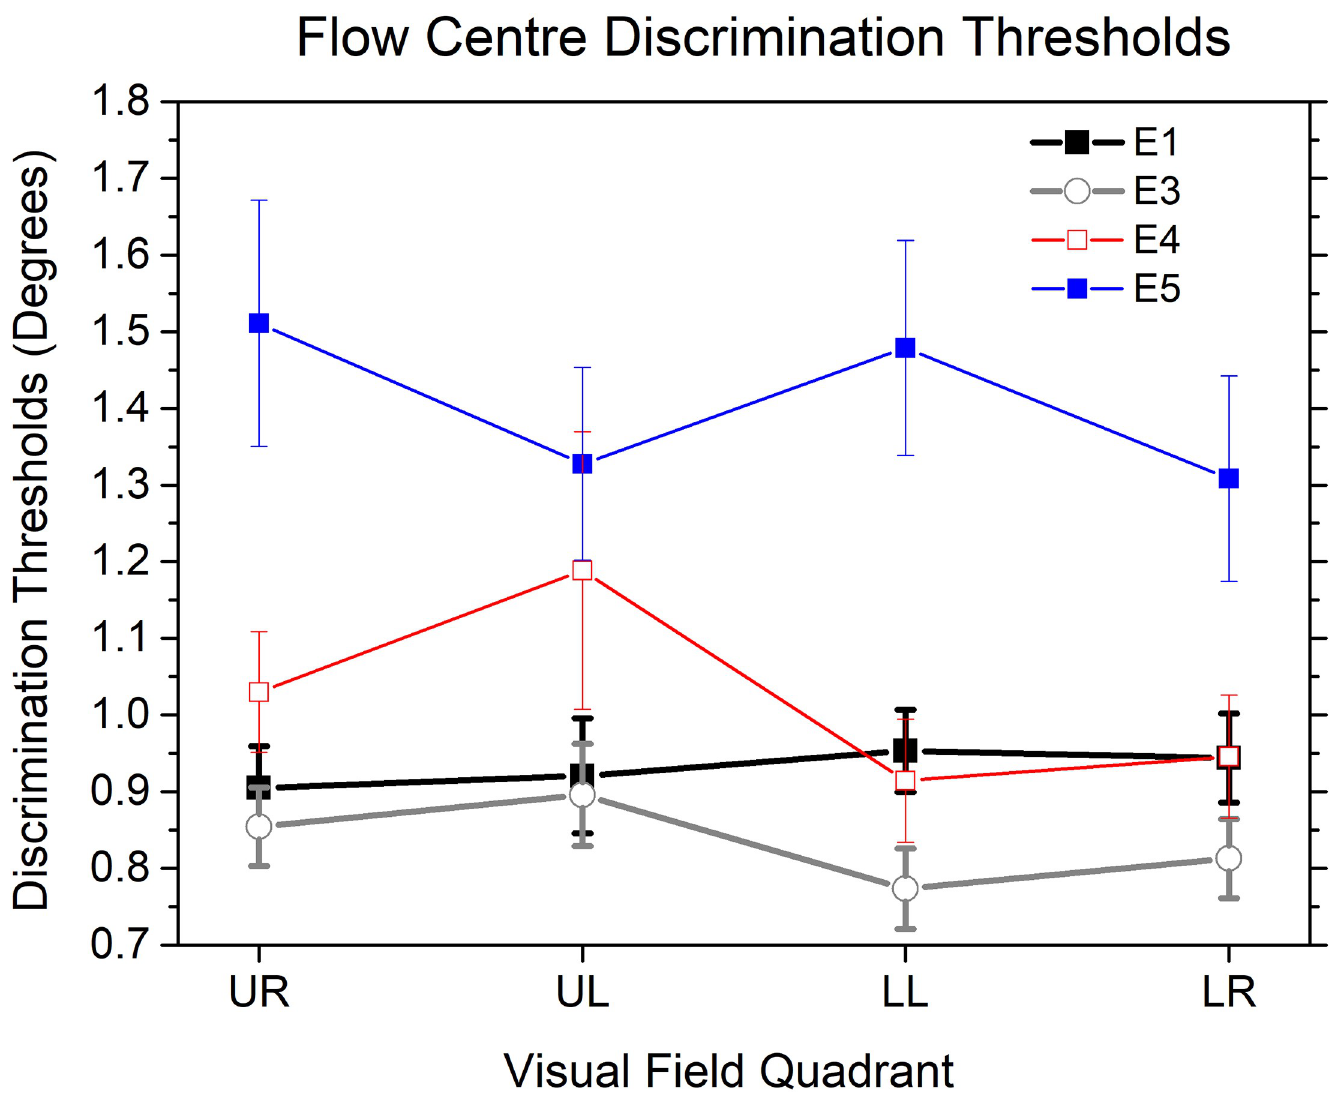
Fig 3. Mean thresholds for discrimination between the centres of two optic flow patterns in each visual quadrant in Experiment 1, 3, 4 & 5. UR: upper right; UL: upper left; LL: lower left; LR: lower right. Experiment 1: E1, black curve. Experiment 3: E3, gray curve. Experiment 4: E4, red curve. Experiment 5: E5, blue curve. Vertical bars represent standard